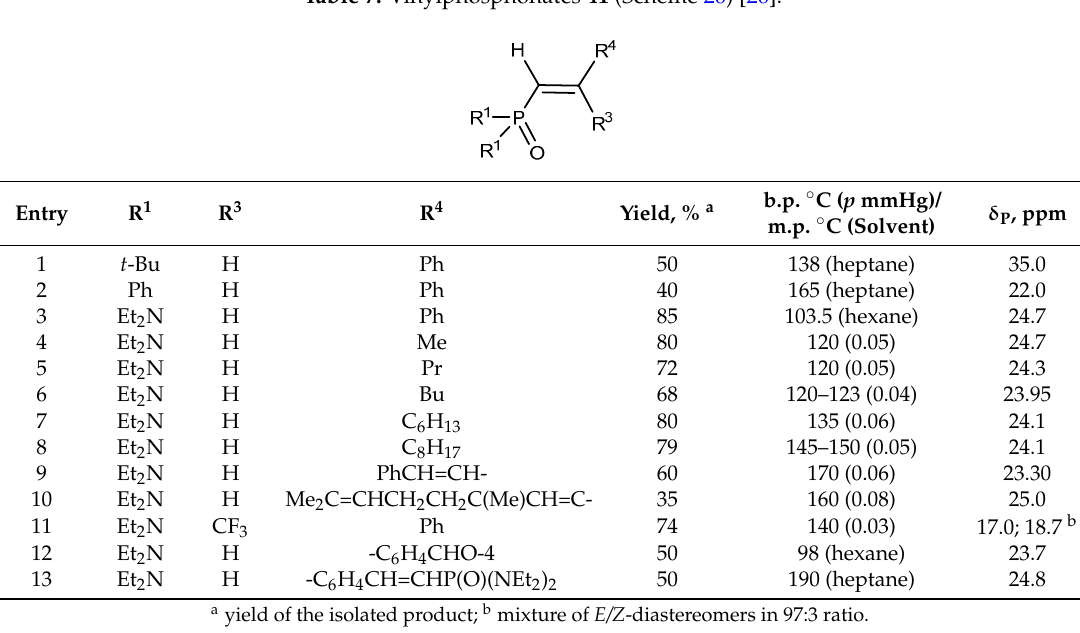
Table 7. Vinylphosphonates 41 (Scheme 26) [26].